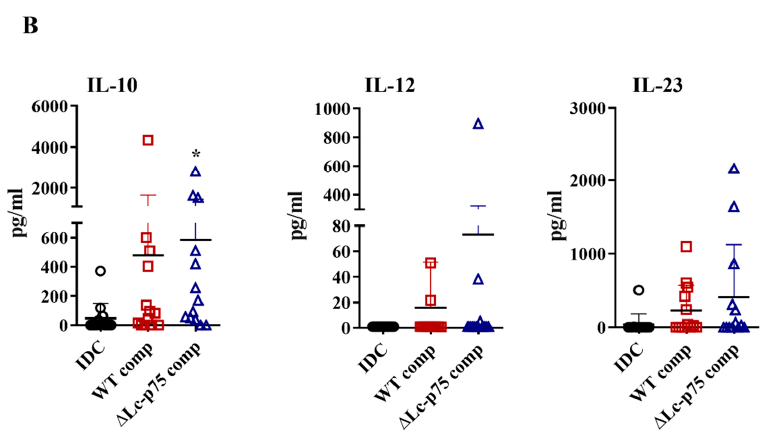
Figure 4. PG derived from wild-type (WT) L. casei BL23 and ∆ Lc-p75 mutant strains induces enhanced cytokine secretion by moDCs independently of the PGH mutation. Five-day moDCs were treated with 10 µ g/mL PG components derived from WT and Lc-p75 mutant strains for 24 h. The concentrations of TNF- α , IL-1 β , and IL-6 proinflammatory cytokines ( A ) and of IL-10, IL-12, and IL-23 T-cell-polarizing cytokines ( B ) were determined using ELISA. The mean of the concentrations was calculated from 11–13 independent experiments. Each dot represents one donor. Student’s paired two-tailed t -test was used in the statistical analysis, with significance defined as * p < 0.05 and ** p < 0.01 compared to the control, nonactivated cells (IDC).